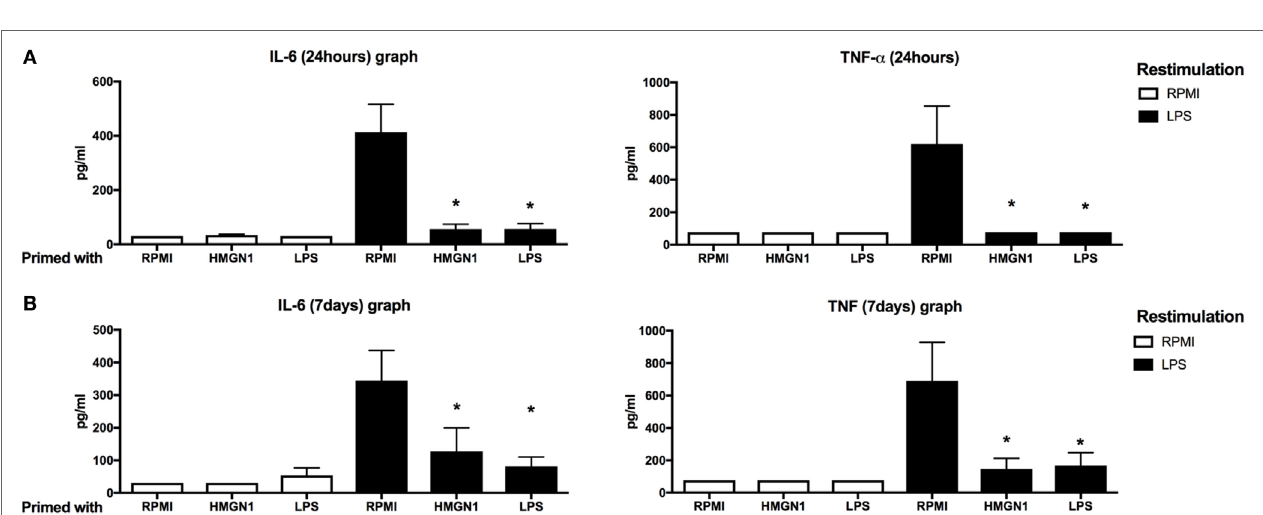
FigUre 2 | High-mobility group nucleosome-binding protein 1 (HMGN1) induces short- and long-term immunotolerance. Human peripheral blood mononuclear cells were primed with recombinant HMGN1 or lipopolysaccharide (LPS) for 24 h and then washed with PBS. The cells were further rested in RPMI containing 10% serum for (a) 24 h or (B) 6 days, and then restimulated with LPS or RPMI for additional 24 h and supernatant was harvested. The IL-6 and TNF- α level were determined by ELISA [ n = 8, * p < 0.05 vs RPMI (LPS restimulated)